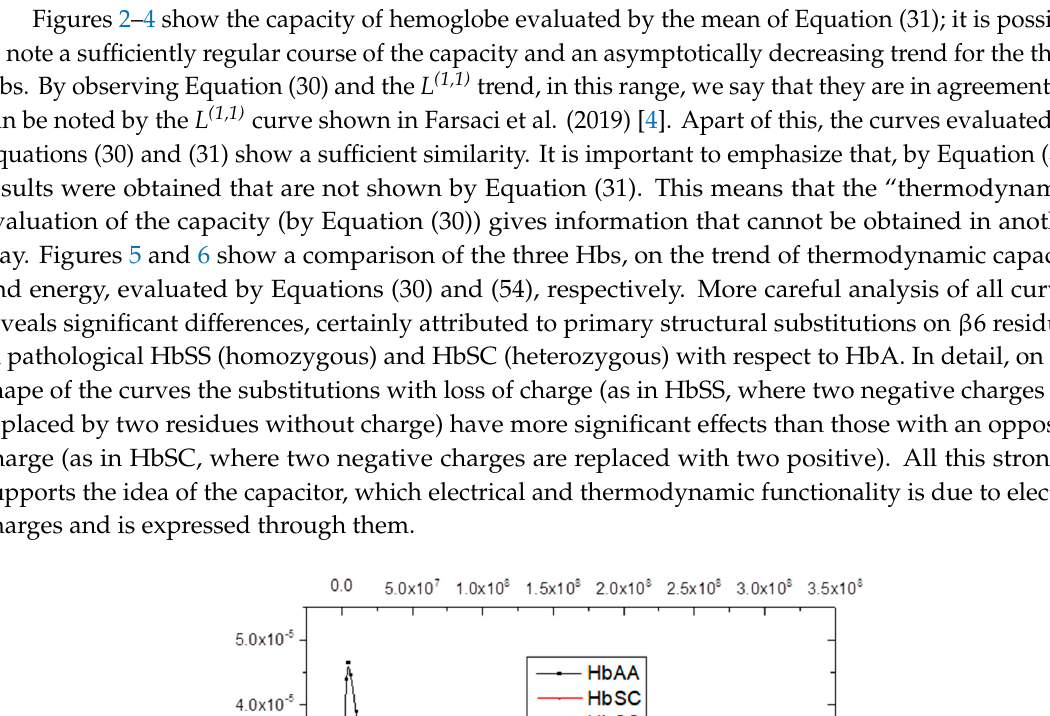
Figure 6. Comparison between HbAA (black line), HbSC (red line) and HbSS (blue line) Energy trend calculated by Equation (54), as a function of frequency. 7. Conclusions The characterization of the Hb, trough the non equilibrium thermodynamic with internal variables allowed for reaching the goal of our study: The formulation of a physical mathematical model of Hb, the “Hemoglobe” a plane capacitor “with non-plane faces” and with dielectric characters. This simple model, which we (etymologically) call hemoglobe, reports the Hb as a geometric figure with the dimensions of 64 Å × 55 Å × 50 Å, very close to its complex biological reality. In a comparative context with the pathological hemoglobins HbSS and HbSC, the capacity that is a function of the angular frequency and the energy of the hemoglobe have been calculated. The phenomenon of conductivity, represented by the term L (1,1) , has been interesting and determinative, because it revealed a capacitive character, therefore neither inductive nor Ohmic and